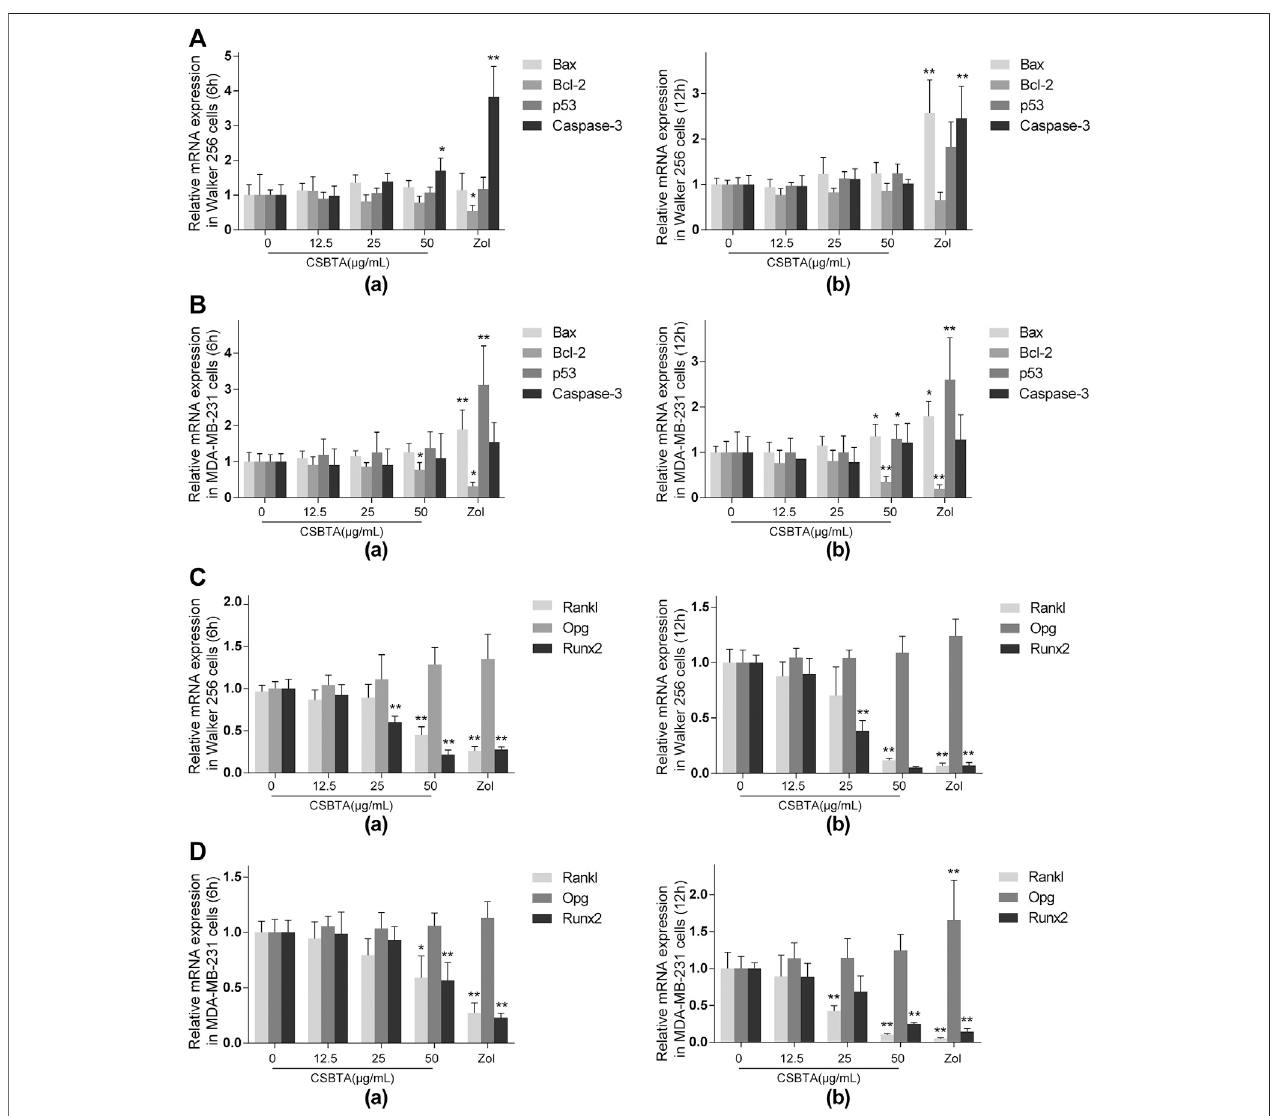
FIGURE 5 | Effect of CSBTA on cytokines in breast cancer cells. The mRNA expression of apoptosis-associated genes Bax, Bcl-2, p53 and Caspase-3 of Walker 256 cells (A) and MDA-MB-231 (B) after treatment with CSBTA or Zoledronic acid (Zol) for 6 and 12 h. The mRNA expression of osteoclast-related genes Rankl, Opg and Runx2 of Walker 256 cells (C) and MDA-MB-231 cells (D) after treatment with CSBTA or Zol for 6 and 12 h. All experiments were repeated for 6 times. Data was expressed as means ± SD and analyzed by one-way ANOVA. * p < 0.05, ** p < 0.01 vs. the 0 μ g/ml CSBTA group.